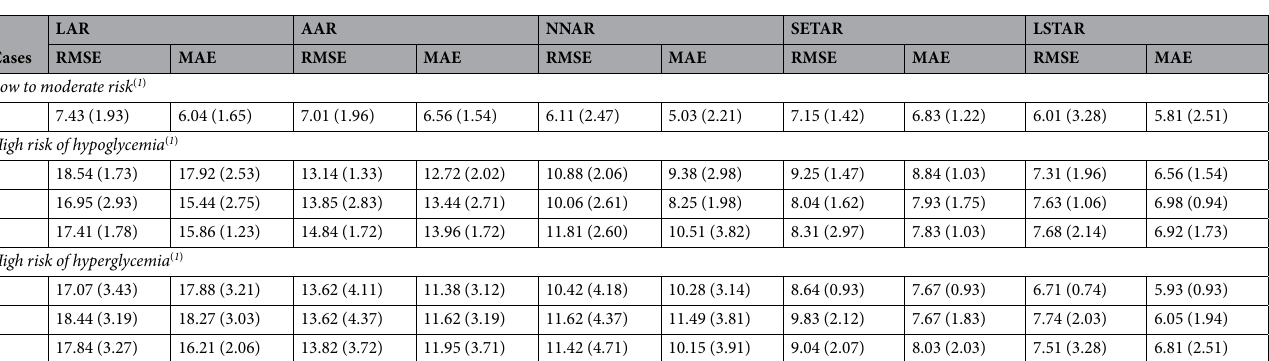
Table 4. Average prediction accuracy of AR models for PH of 60-minutes: RMSE – Root Mean Squared Error ; MAE – Mean Absolute Error . (1) Values are presented as mean (standard